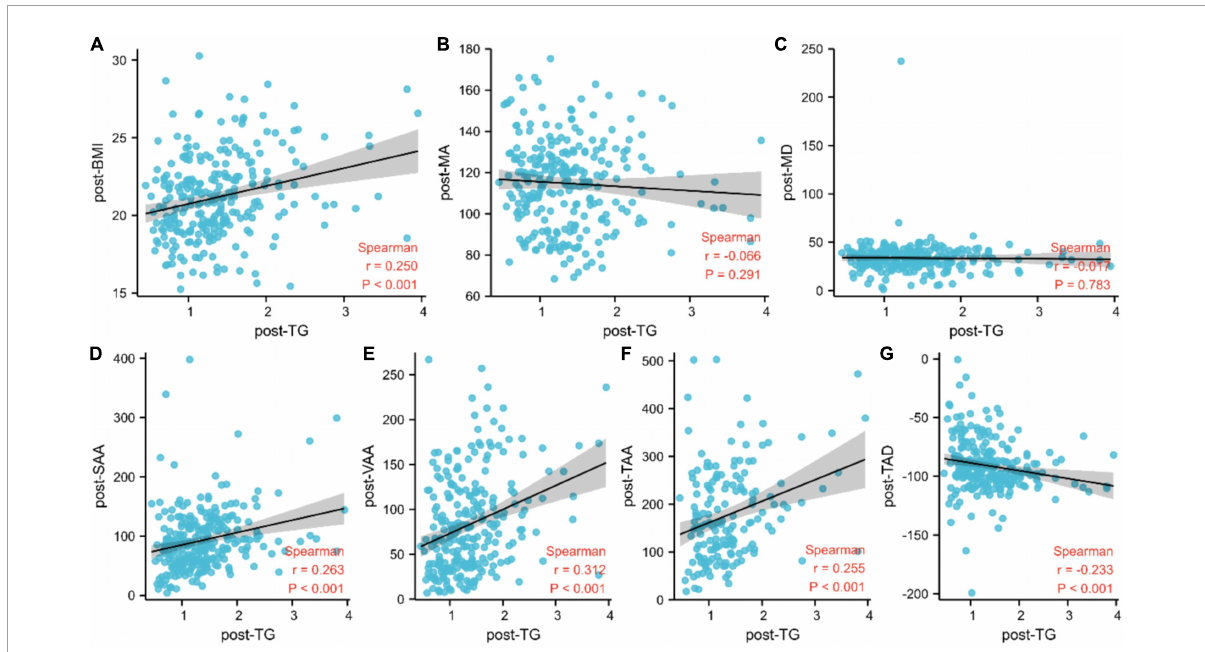
FIGURE4 Associations between post-triglyceride and body composition. (A) BMI, body mass index; (B) MA, muscle area; (C) MD, muscle density; (D) SAA, subcutaneous adipose tissue area; (E) VAA, visceral (INTRA–ABDOMINAL) adipose tissue area; (F) TAA, total adiposity tissue area; (G) TAD, total adipose density; TG,